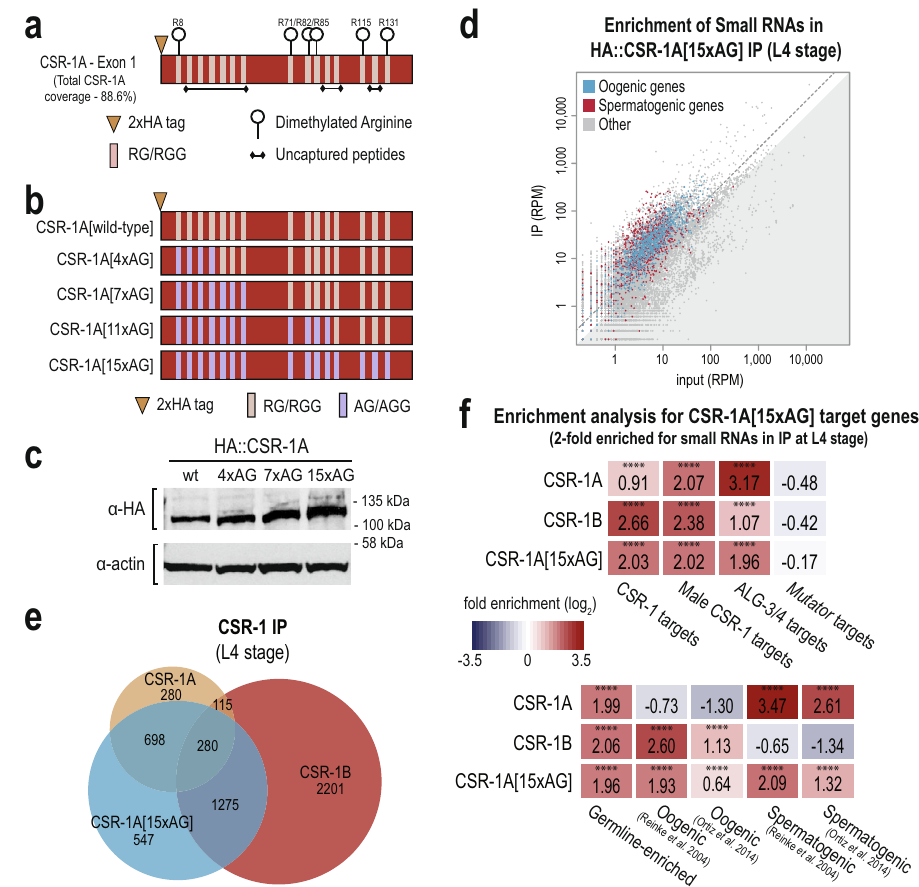
Fig. 6 Methylation of CSR-1A N-terminal exon promotes binding preference for spermatogenic siRNAs. a Graphical display of dimethylation modi fi cations detected on CSR-1A by mass spectrometry following IP. b Schematic representation of the series of arginine to alanine mutations created by CRISPR to generate the unmethylatable CSR-1A[15xAG]. c Western blot for HA::CSR-1A in the RG-to-AG mutants. Actin is shown as a loading control. The blot has been reproduced. d Normalized reads for spermatogenic and oogenic genes (de fi ned by Reinke et al., 2004) from HA::CSR-1A[15xAG] IP compared to input. Spermatogenic and oogenic genes are highlighted in red and blue, respectively. Gray dotted line indicates twofold enrichment in IP relative to input. e Venn diagram indicates overlap of CSR-1A, CSR-1B, and CSR-1A[15xAG] target genes at L4 stage. f Enrichment analysis (log 2 (fold enrichment)) examining the overlap of CSR-1A, CSR-1B, and CSR-1A[15xAG] target genes with known targets of the CSR-1, male CSR-1, ALG-3/4, and mutator small RNA pathways and oogenesis and spermatogenesis-enriched genes. See Materials and Methods for gene list information. Two-tailed p values for enrichment was calculated using the Fisher ’ s exact test function in R. n.s denotes not signi fi cant and indicates a p value >0.05 and **** indicates a p value ≤ 0.0001. See Supplementary Data 7 for more details regarding statistical analysis. Source data are provided as a Source data fi